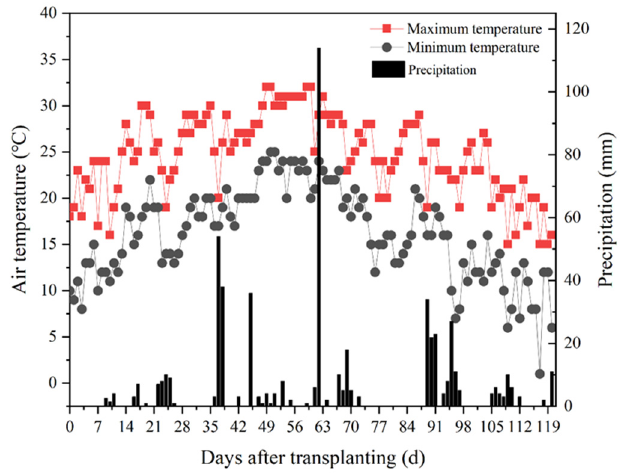
Figure 1. Air temperature and precipitation during rice growth period.